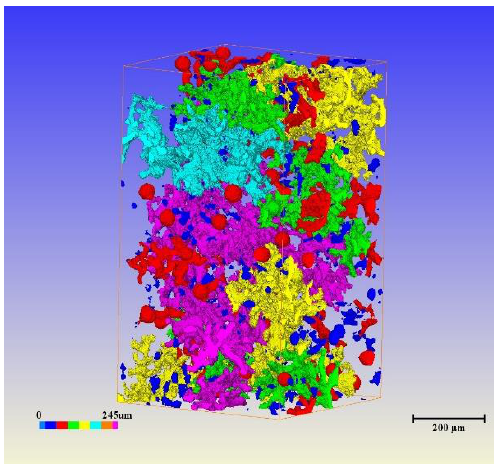
Figure 5. Three-dimensional morphology of graphite in vermicular graphite by XRT. (with 89% vermicular graphite rate).